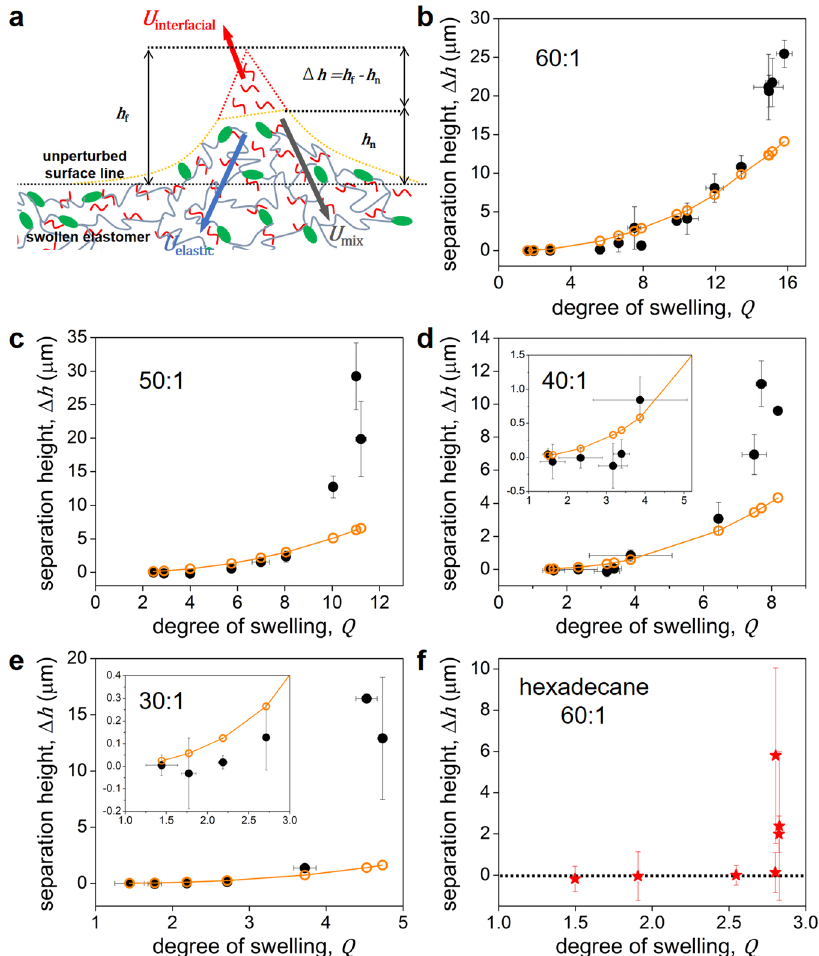
Fig. 7 Comparison of experiments to approximate theory. a Schematic describing the balance of elastic, mixing, and interfacial energy. h n , h f , and Δ h is also described in the schematic. b – e Plots of the experimental ( fi lled black points) and theoretical (Eq. (1), orange open points and lines) separation heights as a function of the degree of swelling with mixing ratios of ( b ) 60:1, ( c ) 50:1, ( d ) 40:1, and ( e ) 30:1. Insets show zoomed-in data of lower swelling for clarity. f Separation height as a function of the degree of swelling of hexadecane swollen 60:1 PDMS. The dotted line is at Δ h = 0. Error bars denote standard